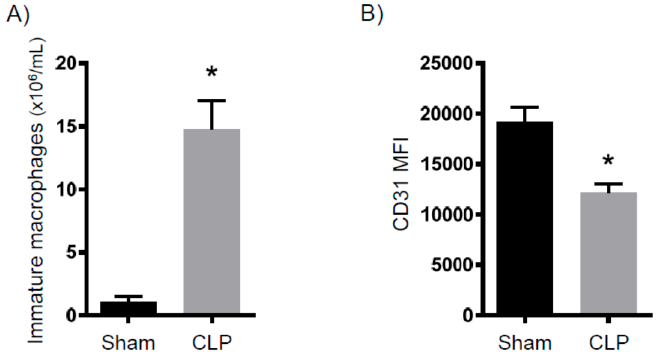
Figure 4. Immature myeloid cells in the spleen eight days after CLP. Mice were subjected to either sham surgery. Eight days later, animals were sacrificed and the spleens were removed. Flow cytometry was then used to characterize the number of ( A ) immature macrophages (sham N = 14, CLP N = 20) and ( B ) the fluorescent intensity of CD31 as a marker of immaturity ( N = 8 for both groups). * p < 0.05 versus sham.